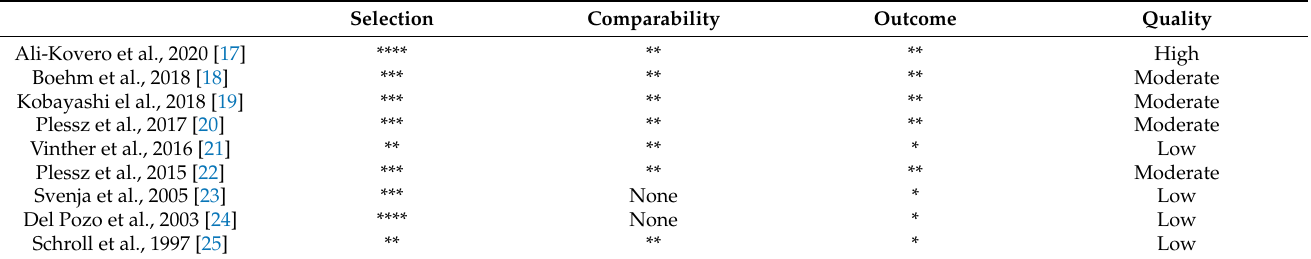
Figure 2. Completion of cross-sectional studies using NHLBI quality assessment tool.